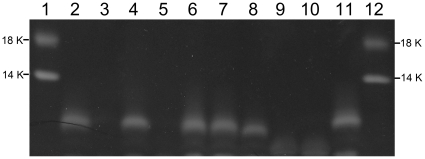
LPS defects in Y. pestis knockout mutants.20 µl of deproteinized lysates [74] were loaded on 14% SDS-PAGE, run and stained with Pro-Q® Emerald 300 Lipopolysaccharide Gel Stain Kit (Invitrogen). 1 and 12, CandyCane™ Glycoprotein Molecular Weight Standards (Invitrogen); 2, CO92 Pgm−; 3, CO92 Pgm−
yrbH, 4, CO92 Pgm−
lpxM; 5, CO92 Pgm−
waaA, 6, CO92 Pgm−
wabC; 7, CO92 Pgm−
wabD; 8, CO92 Pgm−
waaL; 9, CO92 Pgm−
waaF; 10, CO92 Pgm−
hldE; 11, CO92 Pgm−
yrbH (pYrbH).